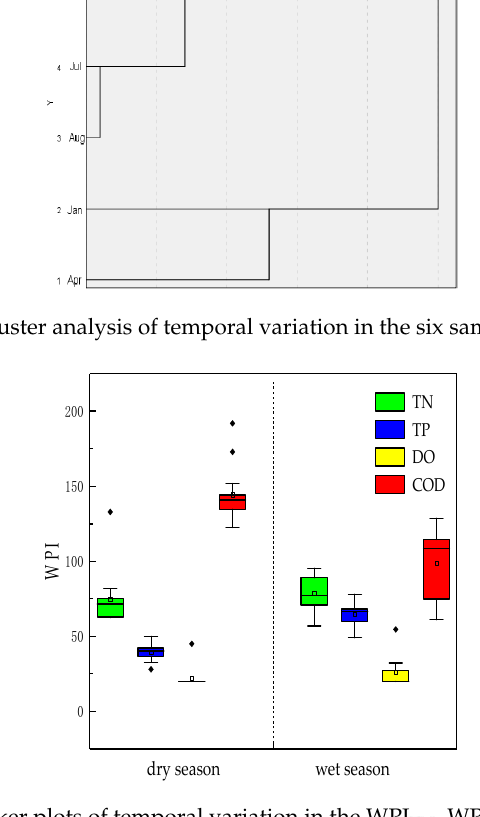
Figure 6. Box and whisker plots of temporal variation in the WPI TN , WPI TP , WPI DO , and WPI COD . During both the dry season and wet season, the WPI COD was always higher than the WPI TN , WPI TP , and WPI DO , and it was the major pollution indicator. The WPI COD was higher in the dry season, with an average value of 135, than in the wet season. However, the average values of the WPI TN , WPI TP , and WPI DO were higher in the wet season than those in the dry season. The monthly variations in the WPI TN , WPI TP , WPI DO , and WPI COD are illustrated in Figure 7. The WPI TN , WPI TP , and WPI DO were higher in the wet season than in the dry season. The WPI COD was higher in the dry season than in the wet season. COD was the major pollution indicator and its WPI value was higher than WPI TN , WPI TP , and WPI DO values in both the dry and wet seasons. DO had the lowest WPI